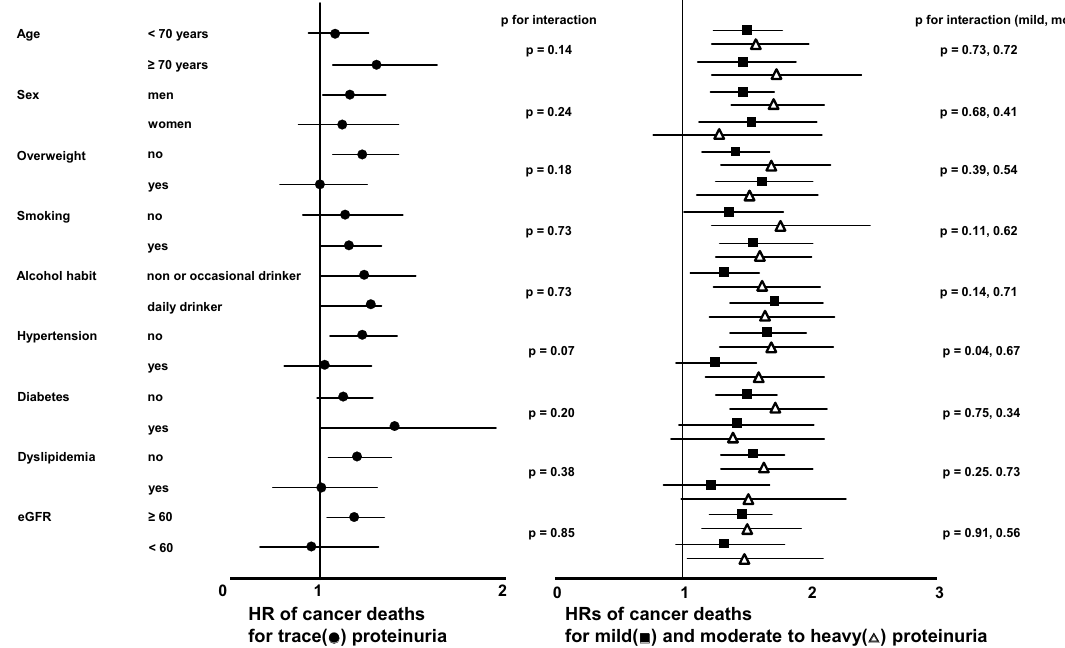
Figure 1. Multivariable-adjusted hazard ratio (95% confidence interval) of cancer death for trace, mild, and moderate to heavy versus negative proteinuria within subgroups stratified by age, sex, overweight, smoking, alcohol habit, hypertension, diabetes mellitus, dyslipidemia, and